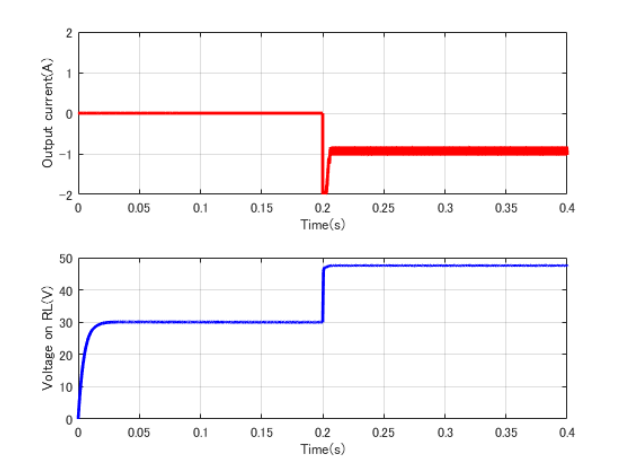
Figure 19. Voltage waveform of full